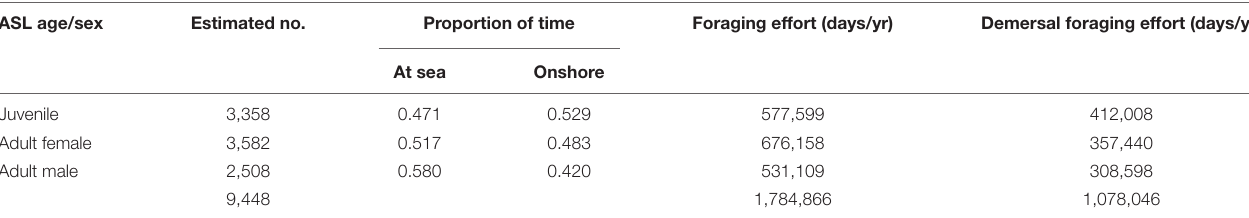
TABLE 1 | Estimates of the number of juvenile, adult female and adult male ASL in the SA population and the proportion of time spent at sea and onshore based on satellite tracking data and their estimated overall total foraging and demersal foraging effort (seal days/yr). ASL age/sex Estimated no. Proportion of time Foraging effort